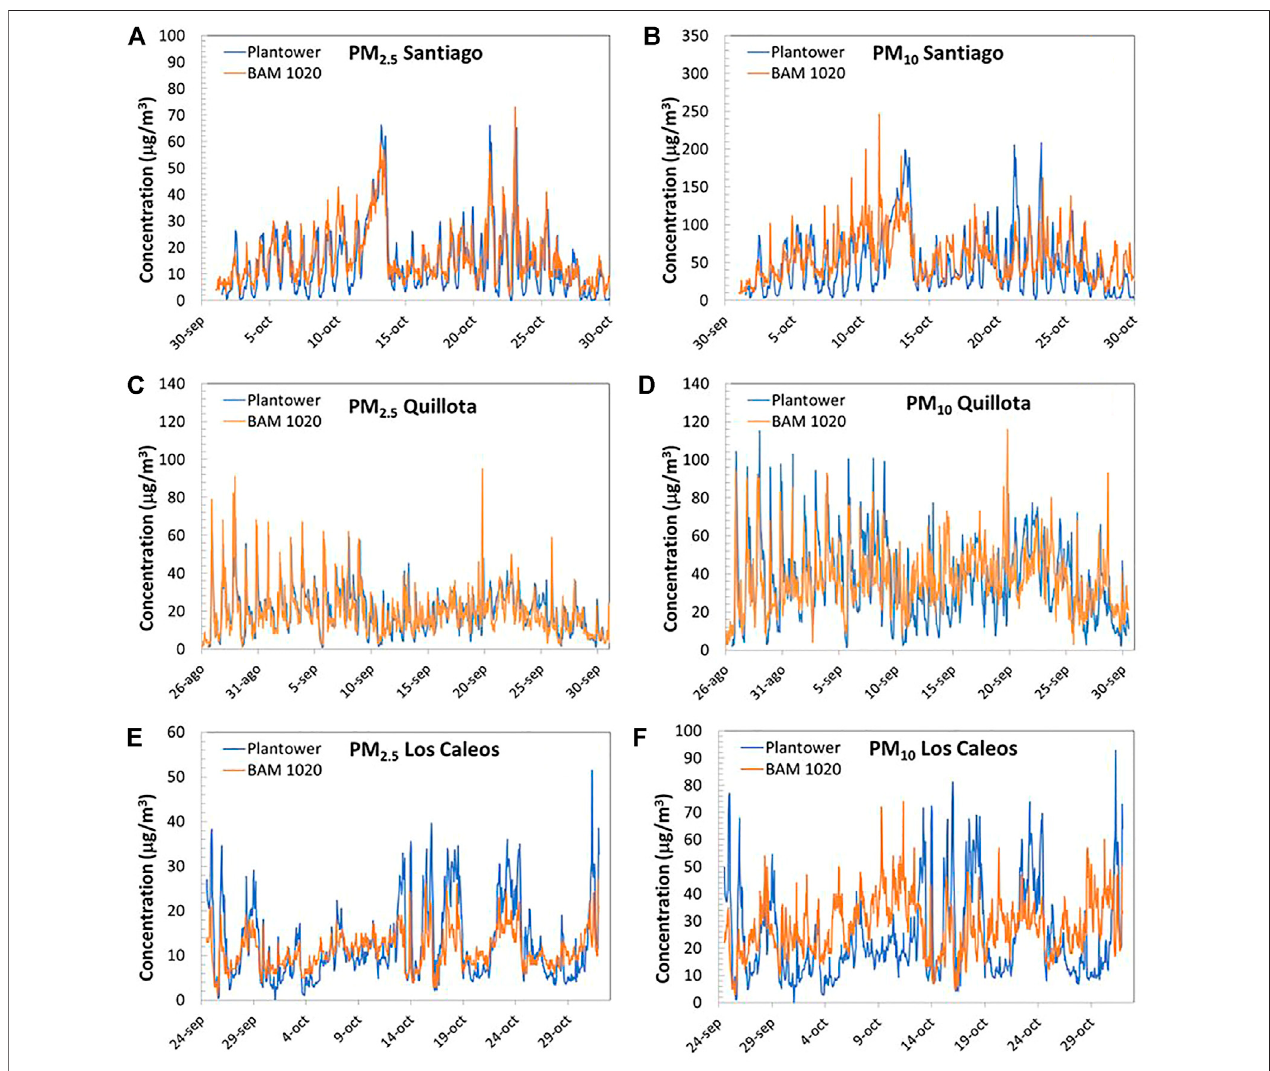
FIGURE 7 | (A) and (B) Time series of the Plantower and BAM in Santiago, from October 1 until November 20, 2019, (C) and (D) Plantower and BAM in Quillota from August 26 until September 30, 2020, (E) and (F) Plantower and BAM in Caleos from September 24 until November 14, 2020.